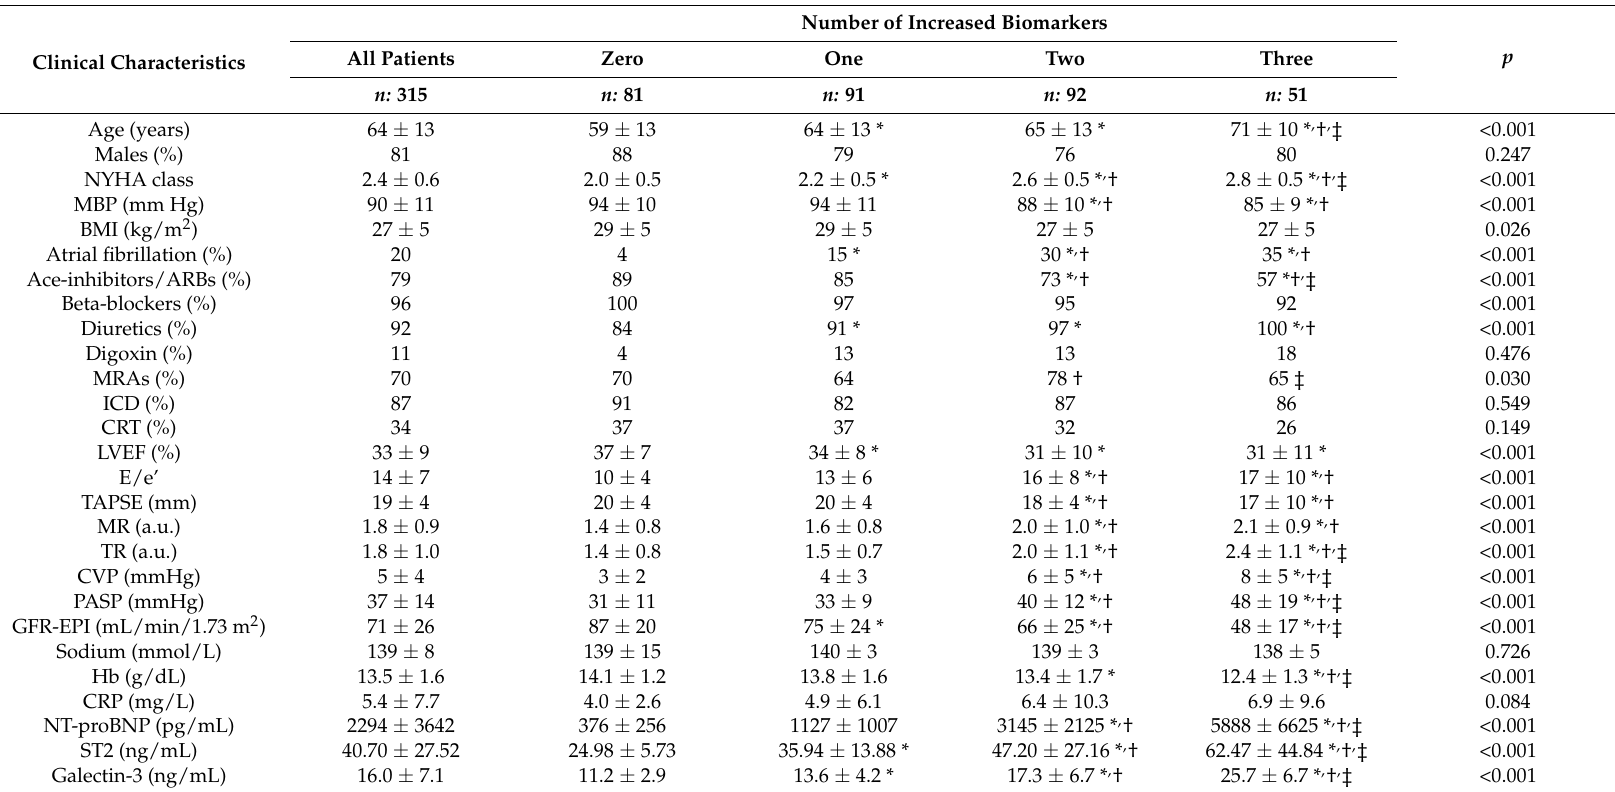
Table 1. Baseline clinical characteristics of all patients and of patients divided according to biomarkers above the cut-off.